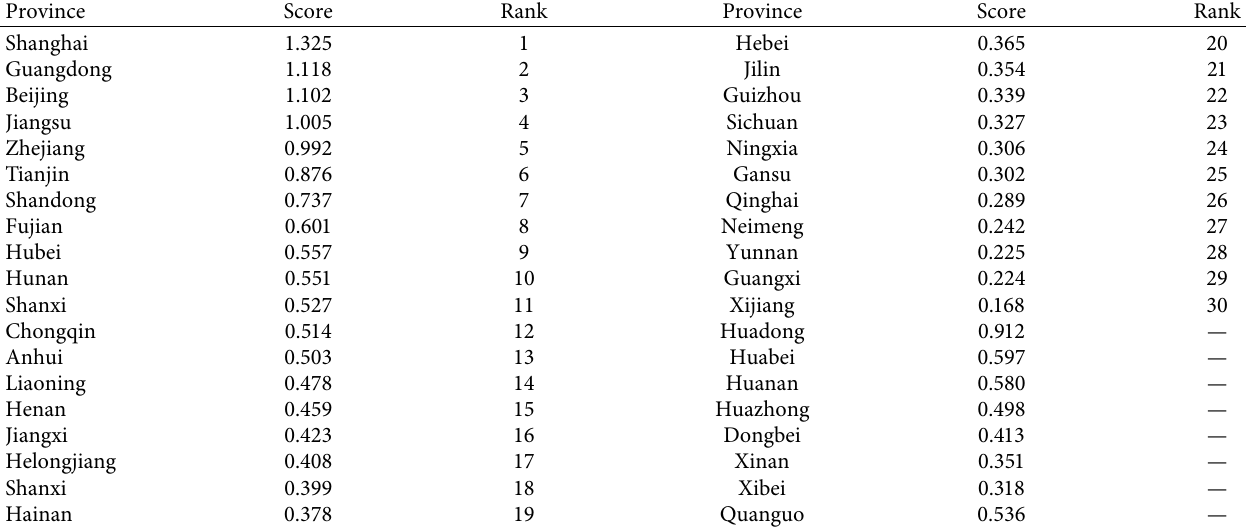
Table 4: Average comprehensive scores of modernized economic systems in various